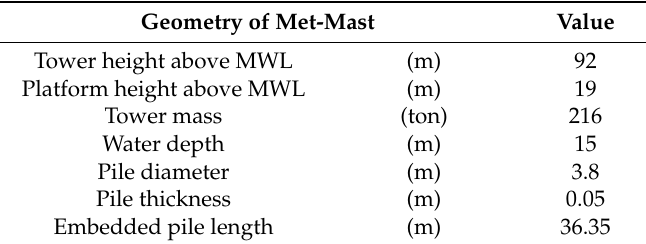
Table 2. Dimensions of TPC’s met mast. MWL: mean water level.